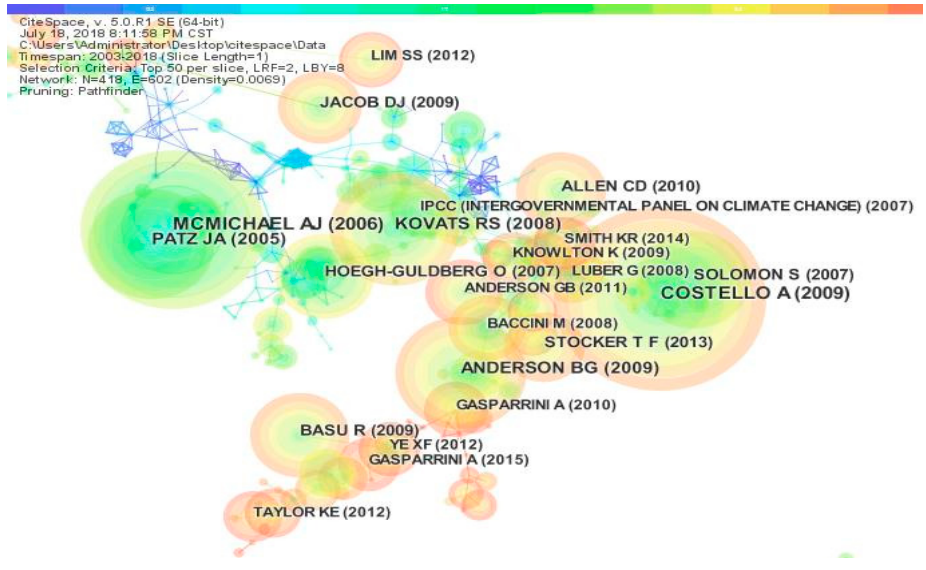
Figure 7. Article co-citation network.